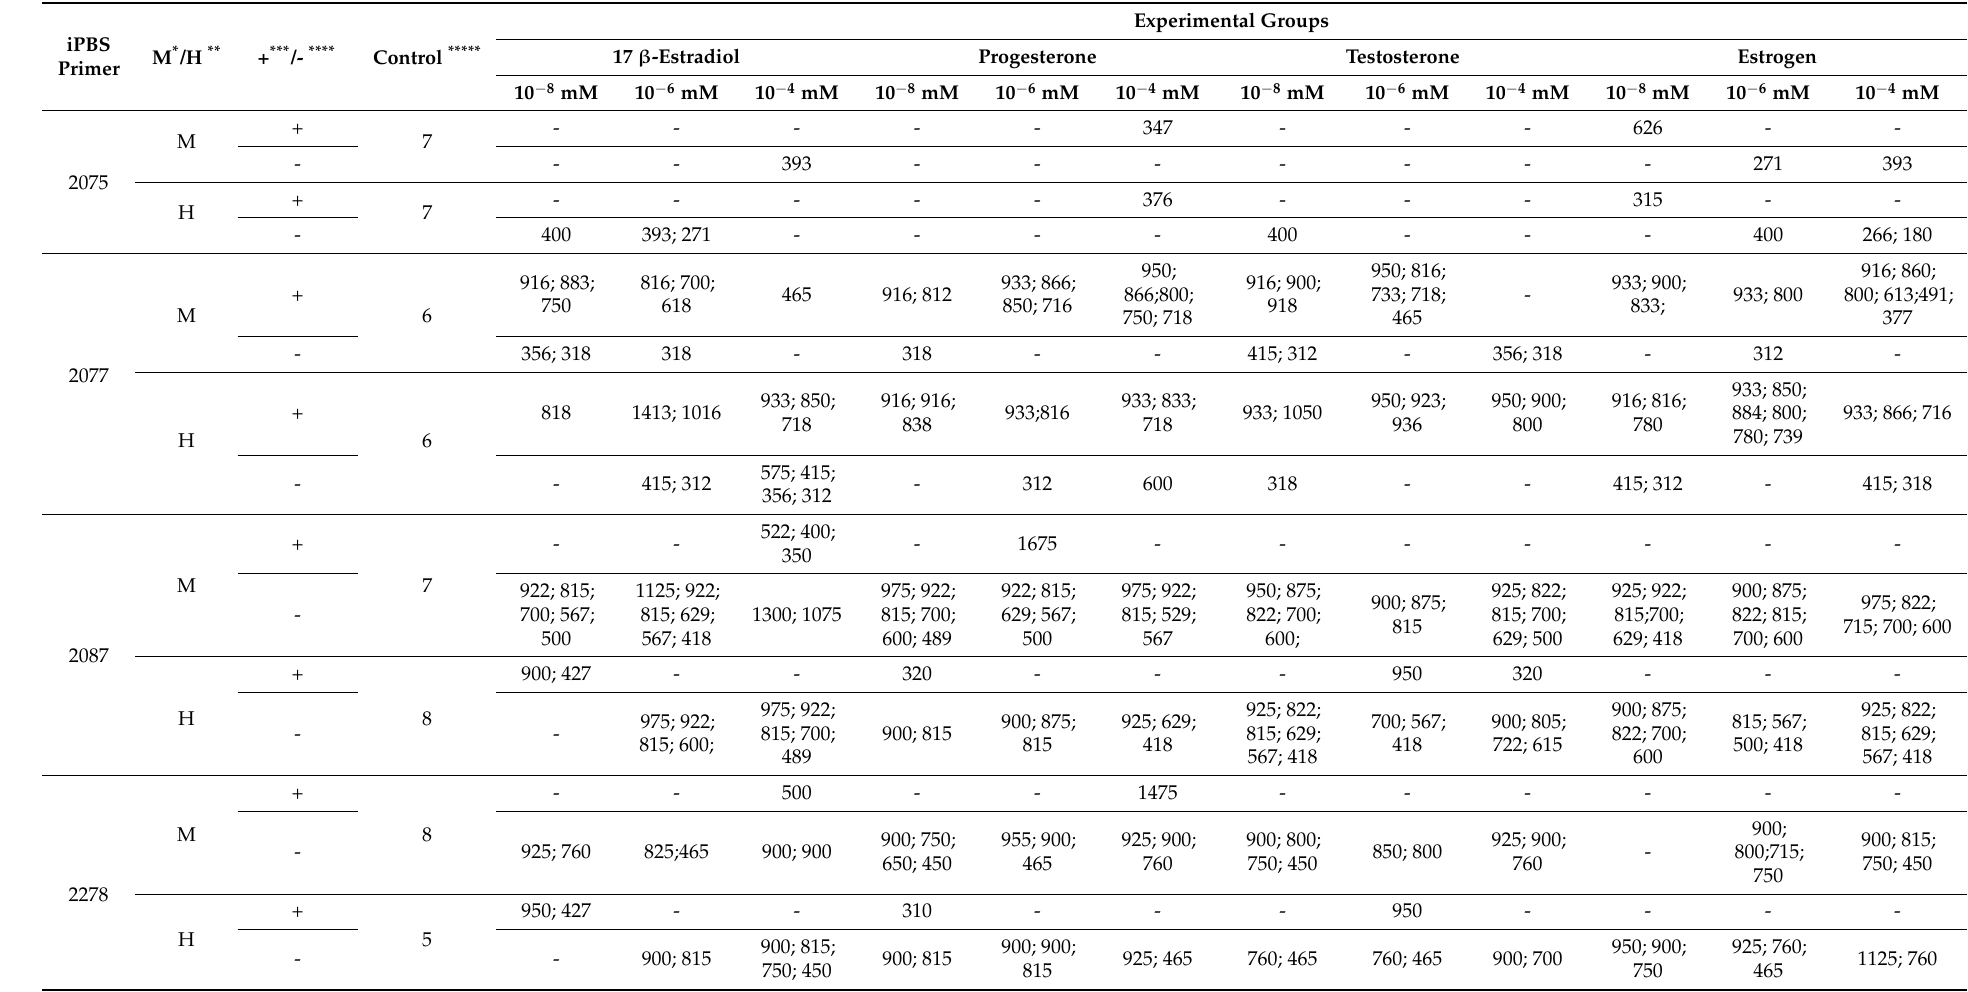
Table 2. Results of CRED-iPBS analysis; molecular size of bands and polymorphism